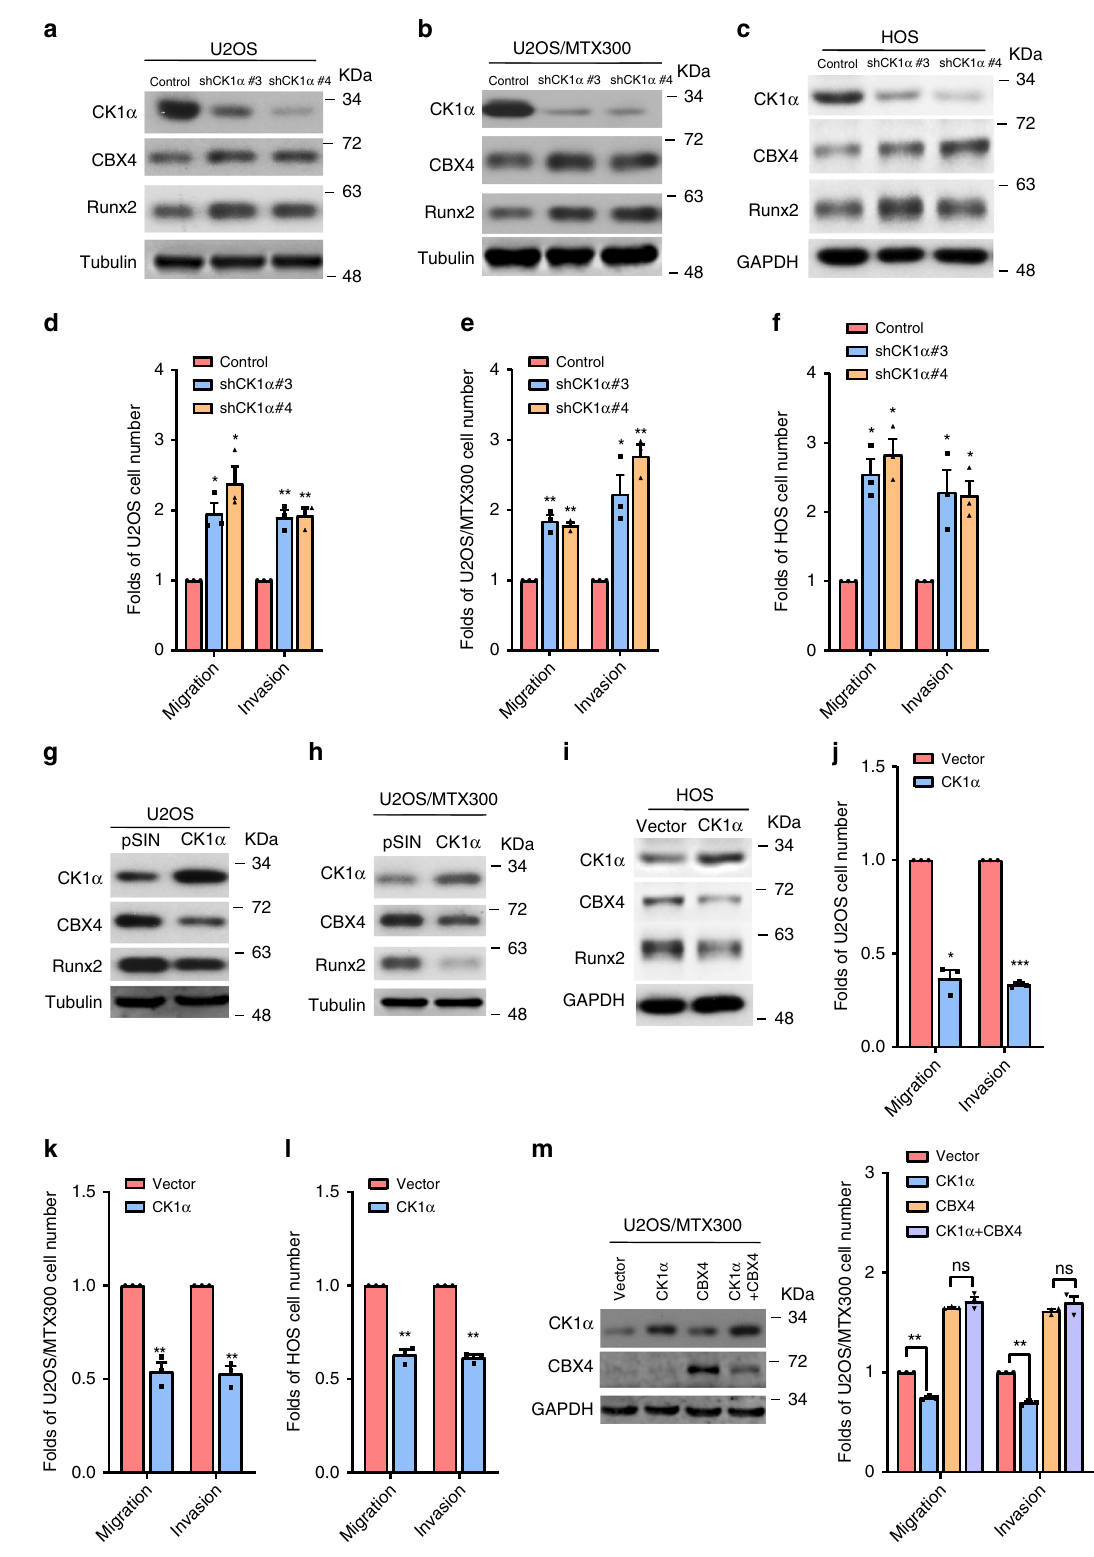
Fig. 5 Inhibition of cell migration and invasion by CK1 α primarily depends on the decrease of CBX4 in osteosarcoma cells. a – c , g – i The indicated proteins were analyzed by Western blotting in the indicated stable cells. d – f , j – l The migration and invasion abilities were determined in the indicated stable cells as described in Methods section. m The indicated U2OS/MTX300 cells were subjected to Western blotting, cell migration and invasion assays. The bars indicate the SD. The results are expressed as the mean ± SD of three independent experiments. * p < 0.05, ** p < 0.01, *** p < 0.001 using the two-sided Student ’ s t -test. n.s no signi fi cance. Source data are provided as a Source Data fi